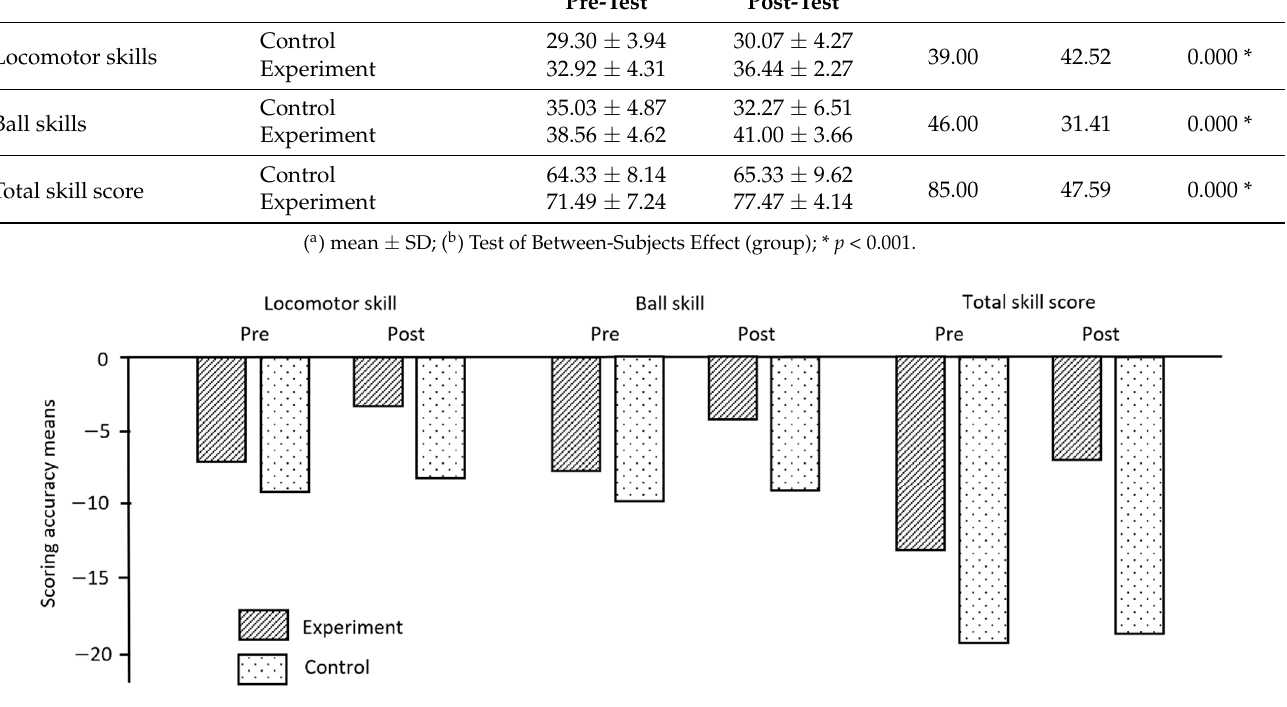
Figure 2. Scoring mean differences in the TGMD-3.